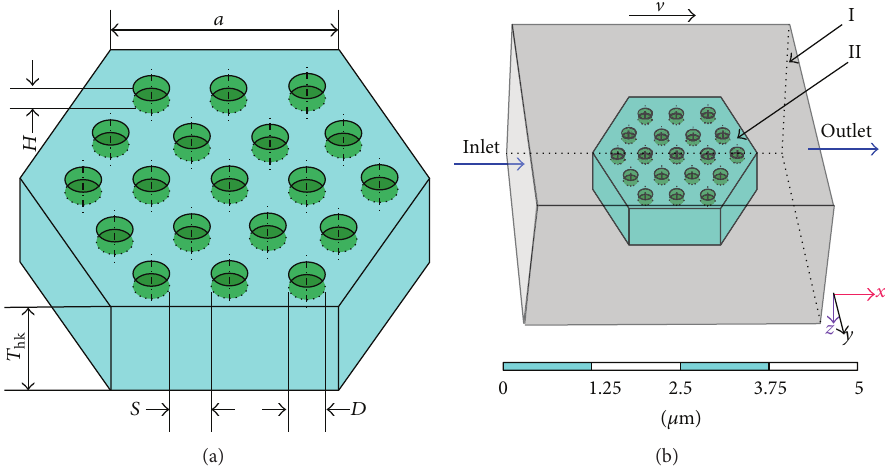
Figure 2: Calculating model: (a) basic unit of the Coscinodiscus sp. frustule and (b) boundary